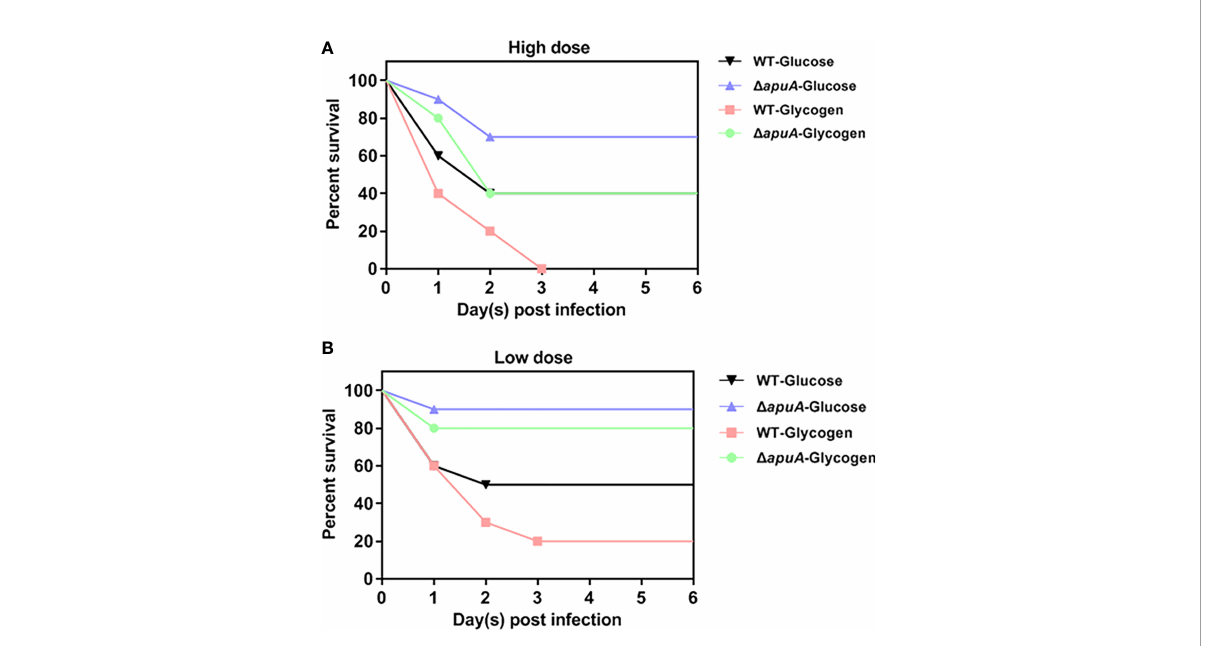
FIGURE 8 Survival curves of worms challenged with (A) high- and (B) low-dose bacteria. Ten worms were used in each group. Eight groups were inoculated with high- and low-dose inoculum. Two groups inoculated with inactivated and glycogen-induced WT bacteria were served as negative controls in the high- and low-dose groups. Survival rates of two negative control groups were 100% (not